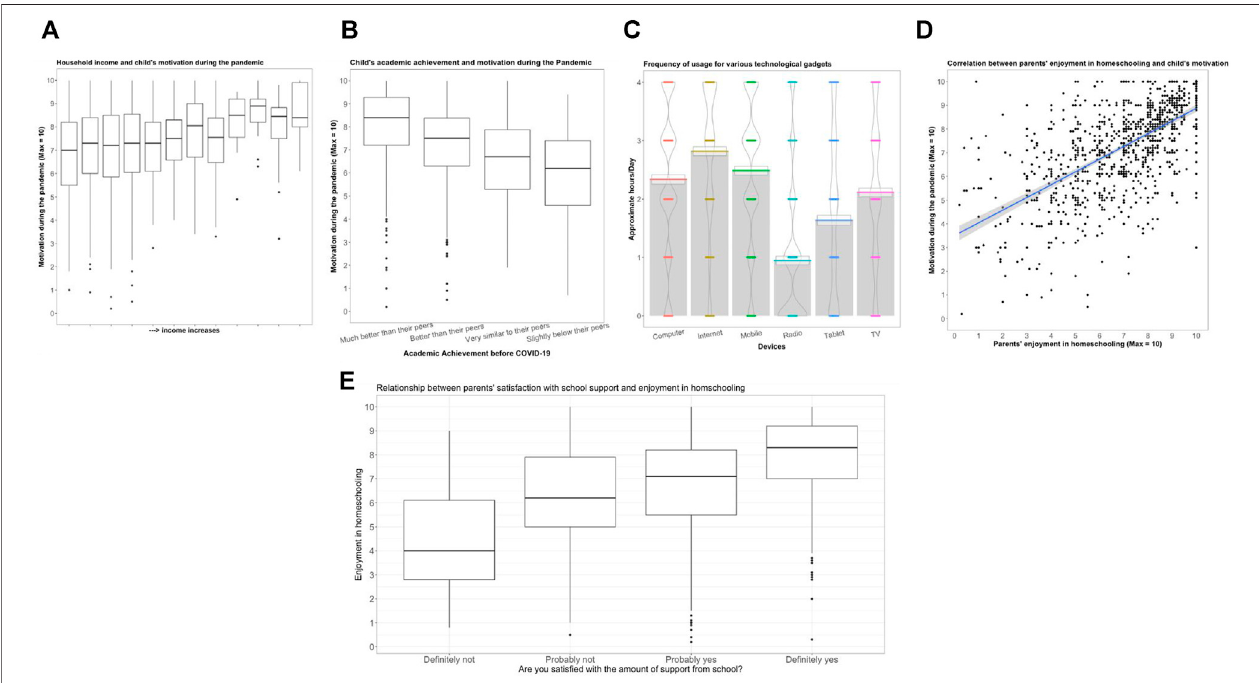
FIGURE 1 | Caption: How (A) ahousehold ’ s annualincome, (B) academicachievement,and (D) parents ’ enjoyment in homeschooling related to thechild ’ s motivation to learnathomeduringthepandemic. (C) showedthefrequencywithwhicheachtechnologicalgadgetwasusedbythechildrentoaccesslearningmaterialsduringthepandemic. (E) showed the association between parents ’ enjoyment in homeschooling and their satisfaction with the support provided by their children ’ s